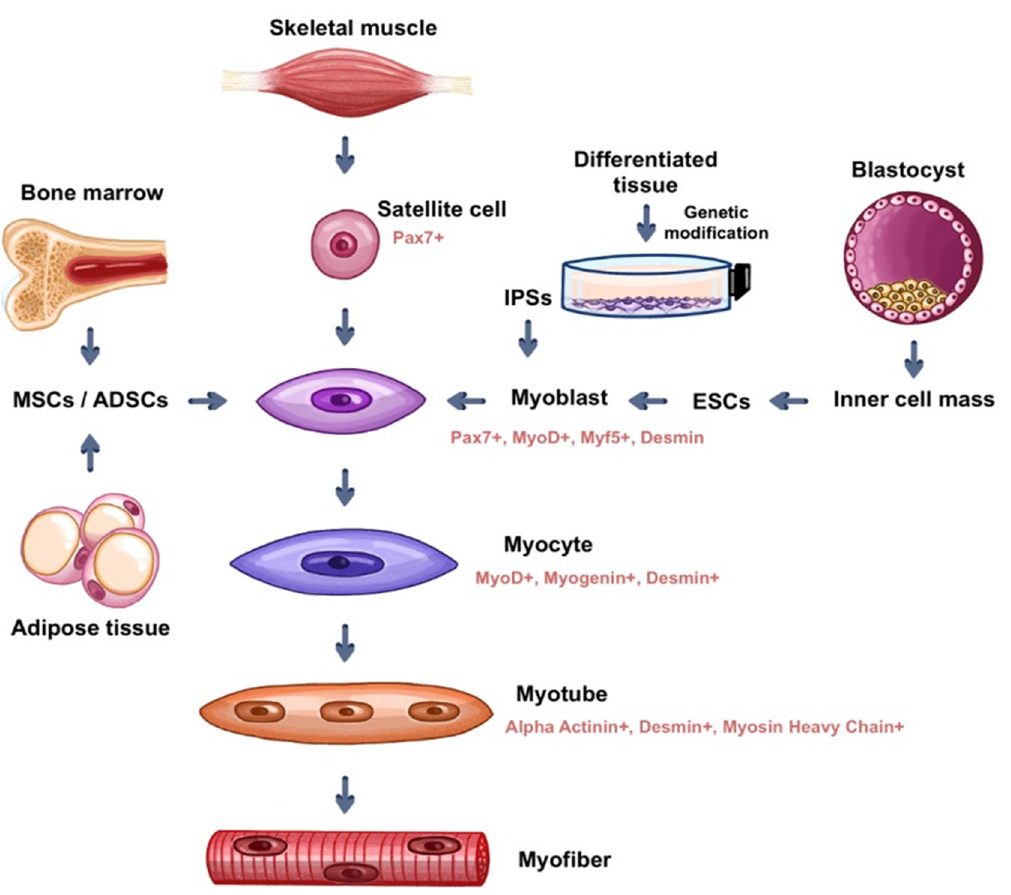
Figure 2. Myogenic cells most used in tissue engineering applied to skeletal muscle (source: prepared by the authors).